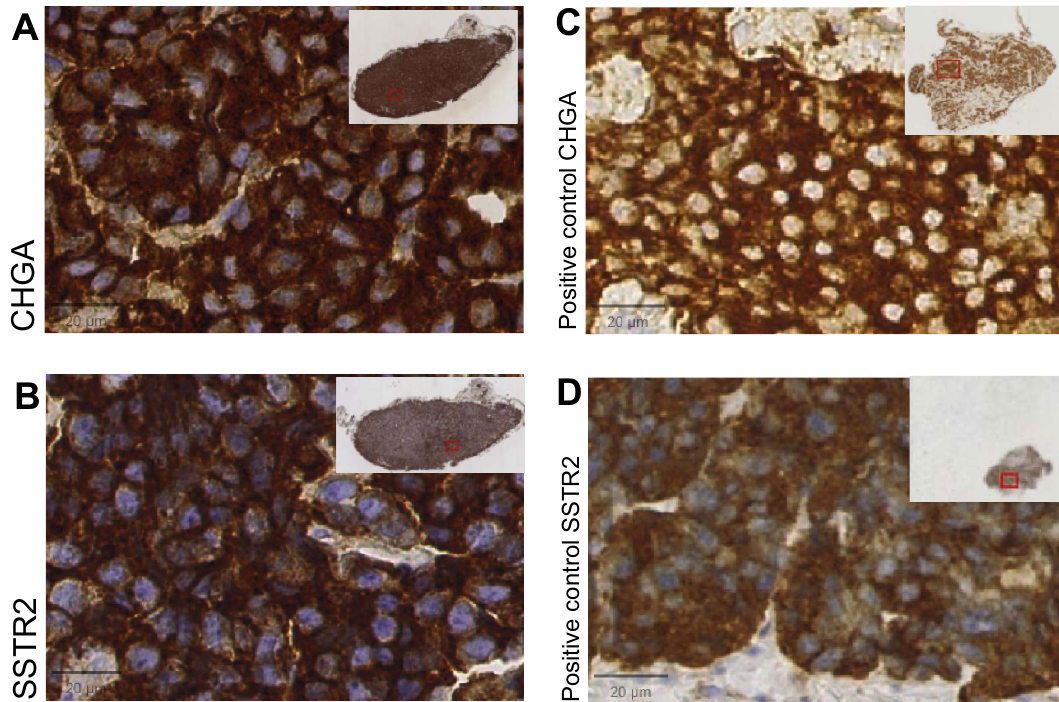
Figure 5. Expression of CHGA and SSTR2 in representative GOT1 tumors ( A,B ) and human small intestinal NETs used as positive controls ( C,D ). The two NET markers SSTR2 and CHGA were highly expressed in all GOT1 tumors included in the study. Black bar = 20 μm. Figure was produced using GraphPad Prism version 9.3.1 (https:// www. graph pad. com/ scien tific- softw are/